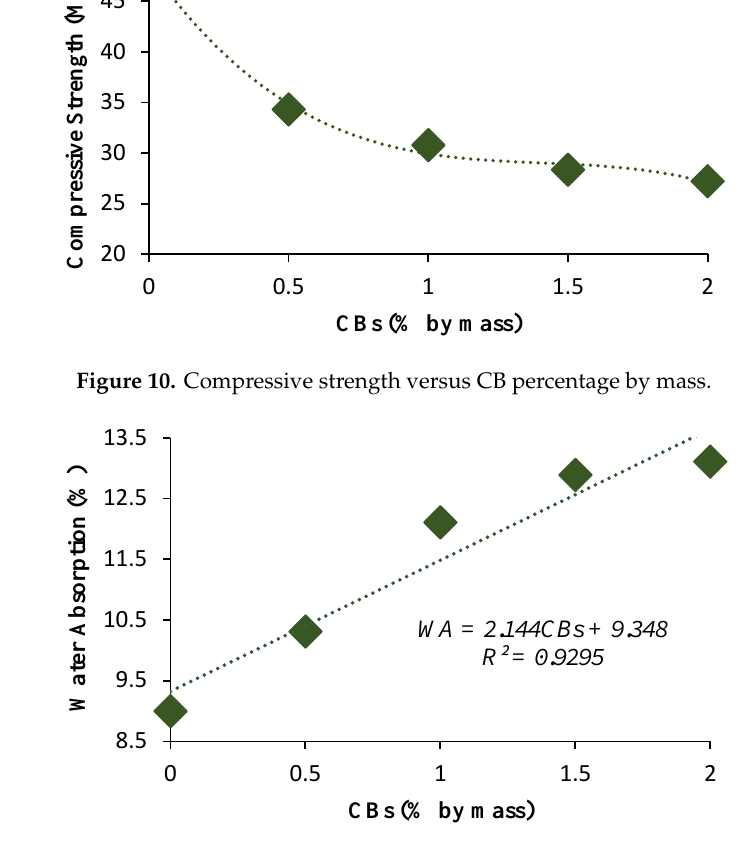
Figure 11. Water absorption versus CB percentage by mass.